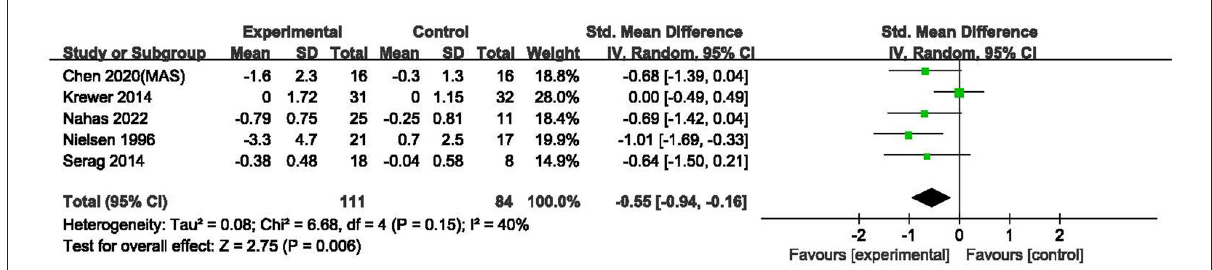
FIGURE4 Meta-analysis of the effect of rPMS on spasticity measured with Ashworth scale, modified Ashworth scale, and modified Tardieu scale.